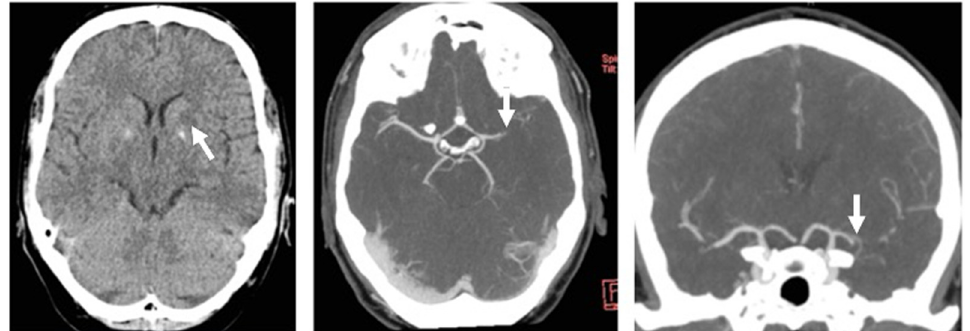
Figure 1. Left : unenhanced CT, putaminal hypodensity (arrow), ASPECTS score 9; middle : axial maximum intensity projection (MIP) reconstruction of CT-angiography showing left MCA occlusion (arrow); right : coronal MIP reconstruction of left MCA occlusion (arrow), good leptomeningeal collaterals can be seen.